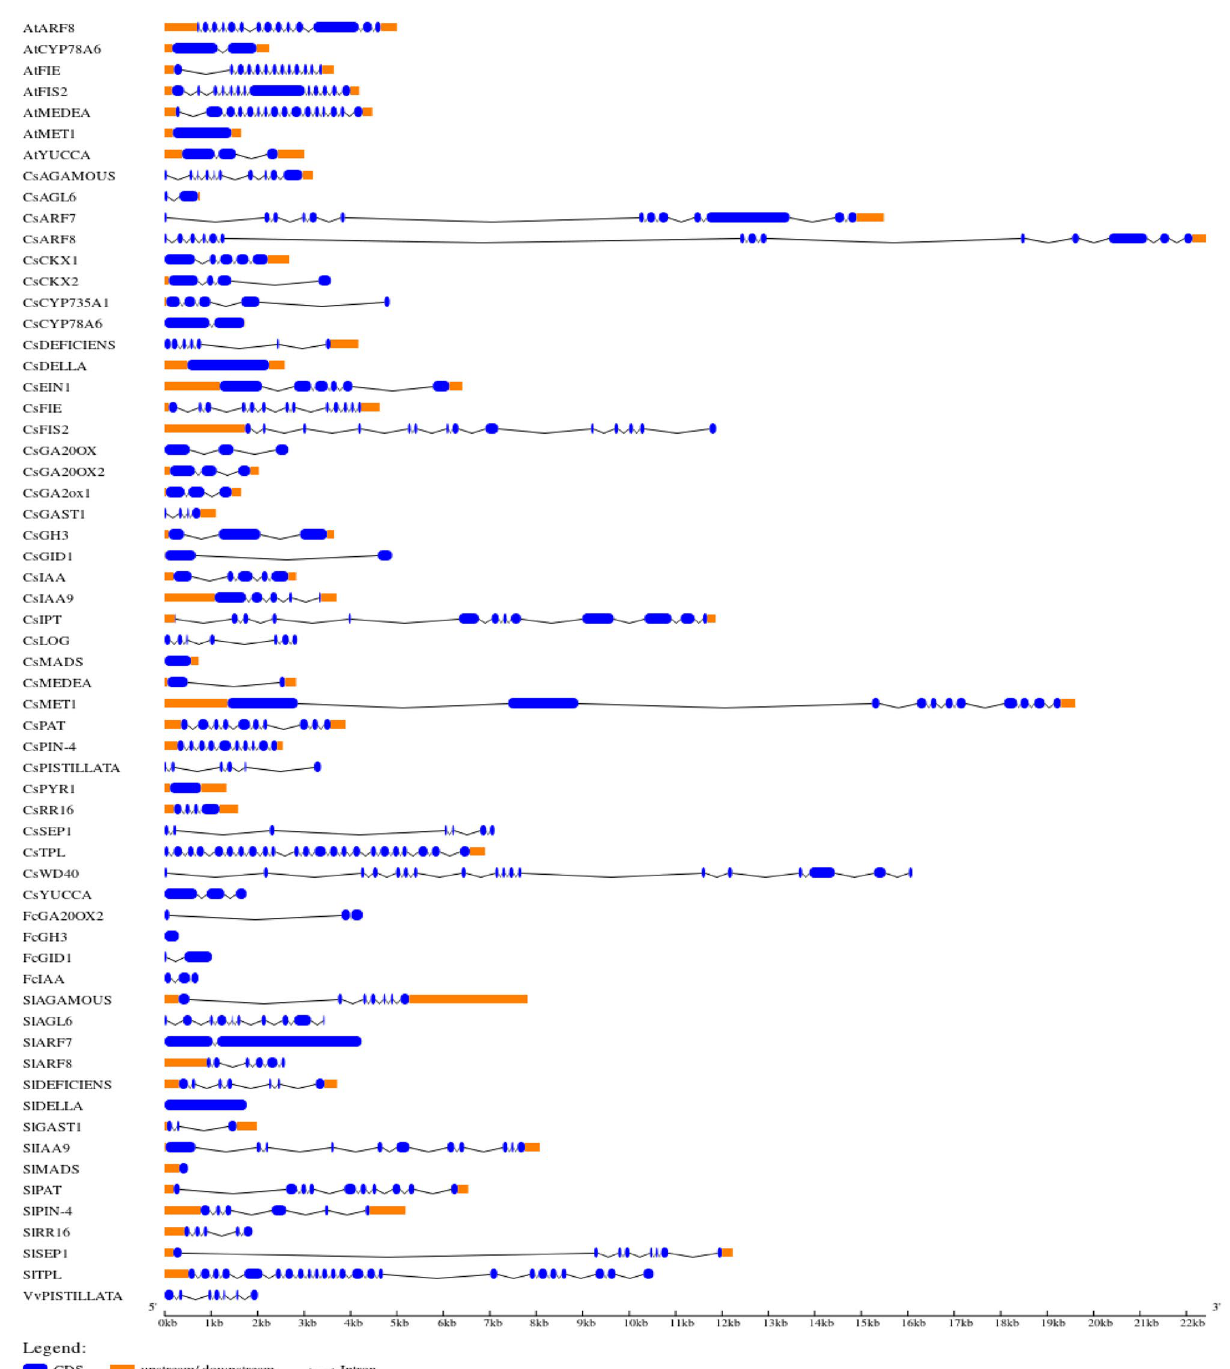
Figure 2. Intron–exon structures of cucumber PRGs and their reference genes from different crops. Exons and introns are shown by blue rectangles and thick black curved lines, respectively. Lengths of exons are fit to scale (At: Arabidopsis thaliana; Fc: Ficus cracia; Sl: Solanum lycopersicum; Vv: Vitiv vinifera